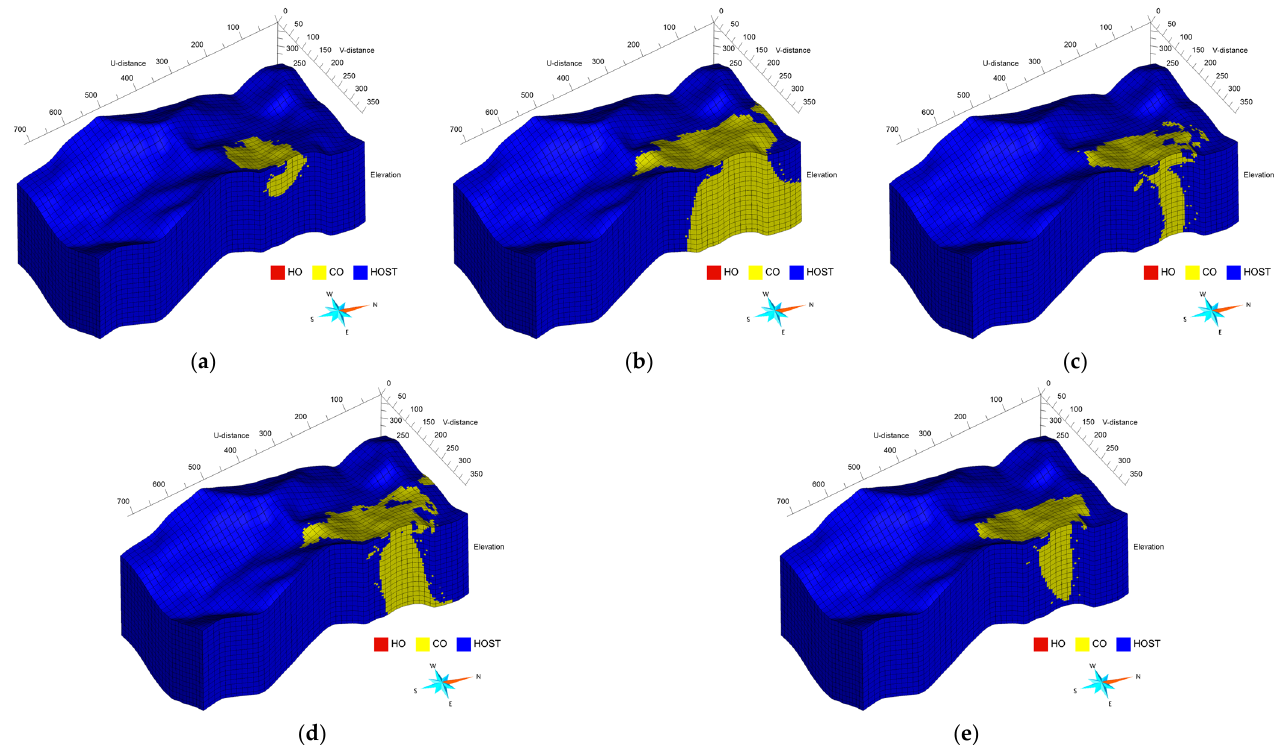
Figure 7. Classification results obtained in the survey area with inverted geophysical properties as features, obtained using trained ML models: ( a ) SVM, ( b ) RF, ( c ) extreme gradient boosting (XGB), ( d ) lightGBM (LGBM), and ( e ) DNN.